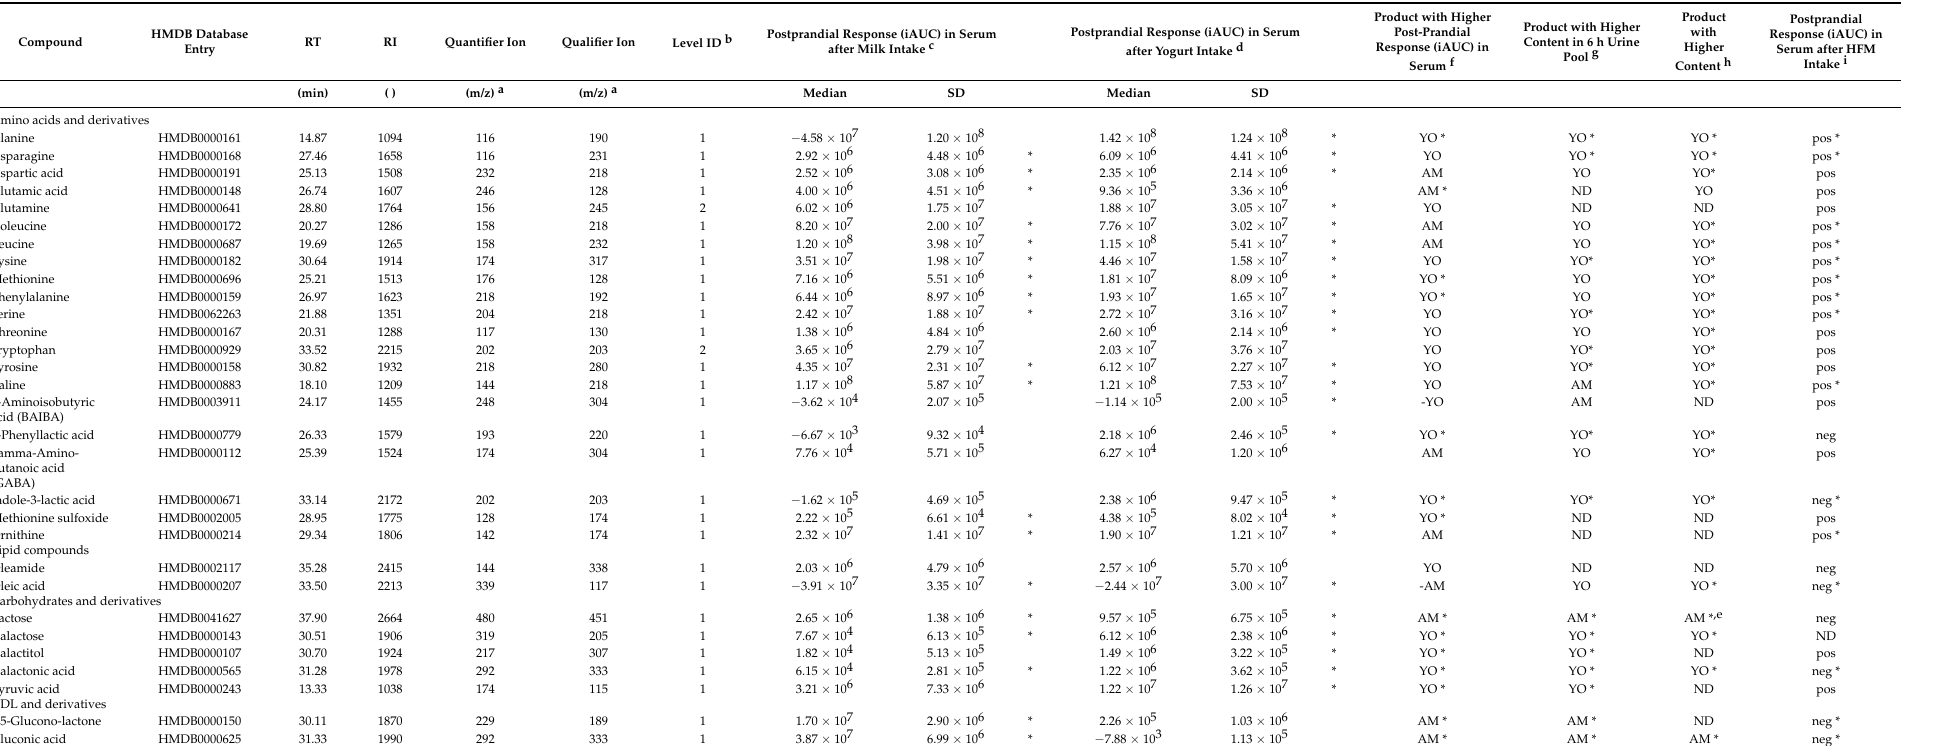
Table 1. Characteristics of postprandial active metabolites derived from the GC-MS analysis with derivatisation after the intake of milk (AM), yogurt (YO), and high-fat meal (HFM) by healthy